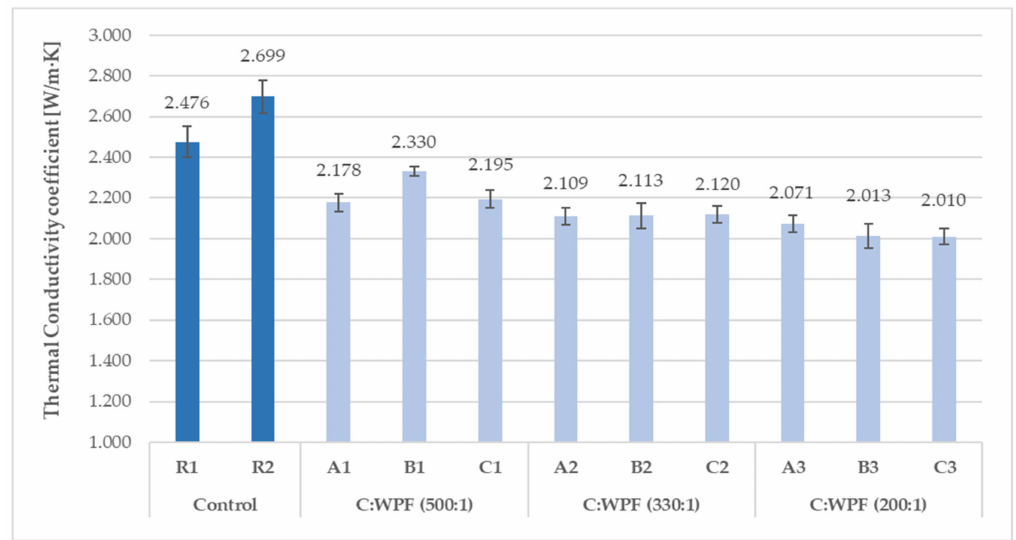
Figure 9. Thermal conductivity coefficients for 28-day hardened fiber-cement mortars (set I) with different C/WPF ratios.